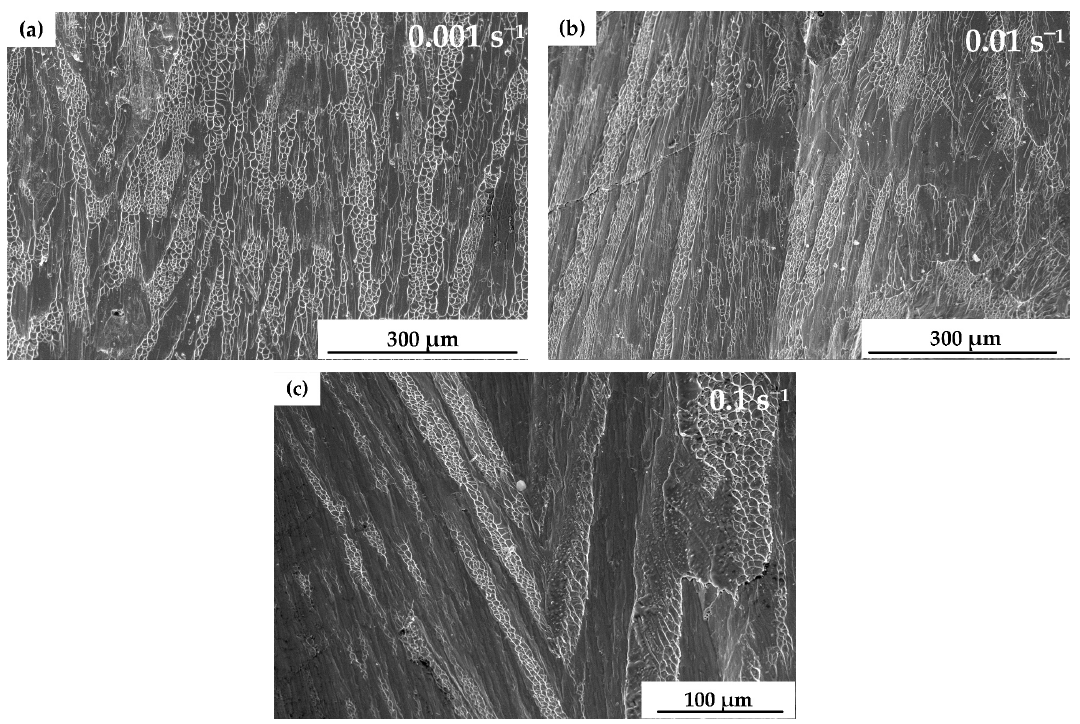
Figure 5. SEM micrographs of the fracture surface of quasi-static compressive tests. ( a ) 0.001 s − 1 , ( b ) 0.01 s − 1 , and ( c ) 0.1 s − 1 .